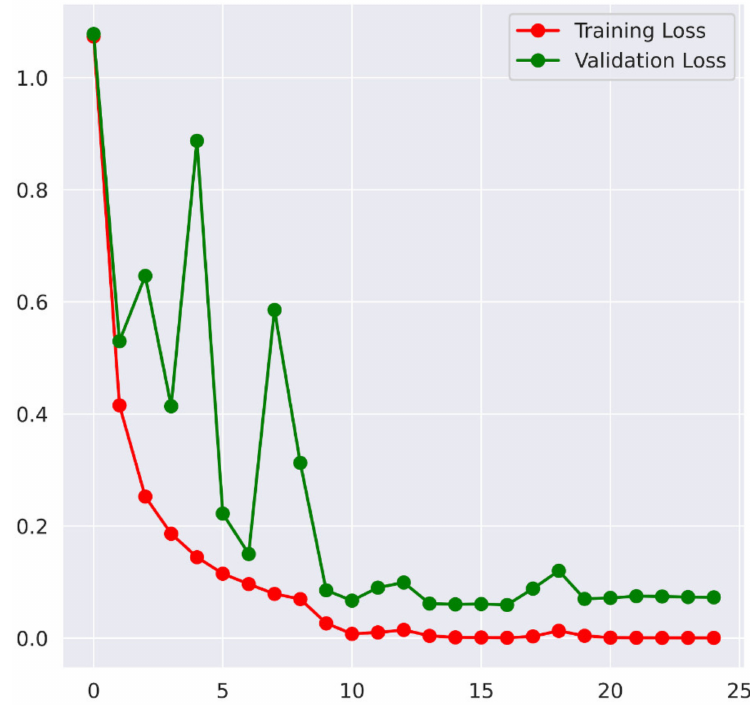
Figure 11. Training and testing losses for Protocol-III.